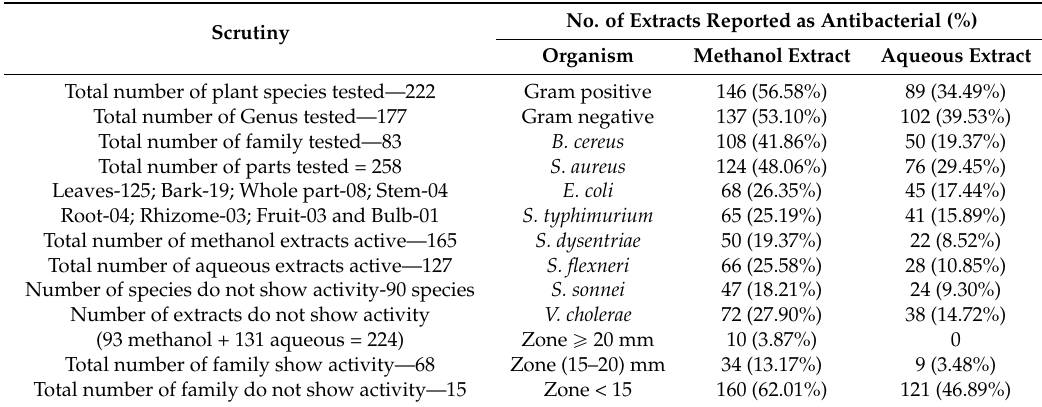
Table 3. Summary of antibacterial activity among the test